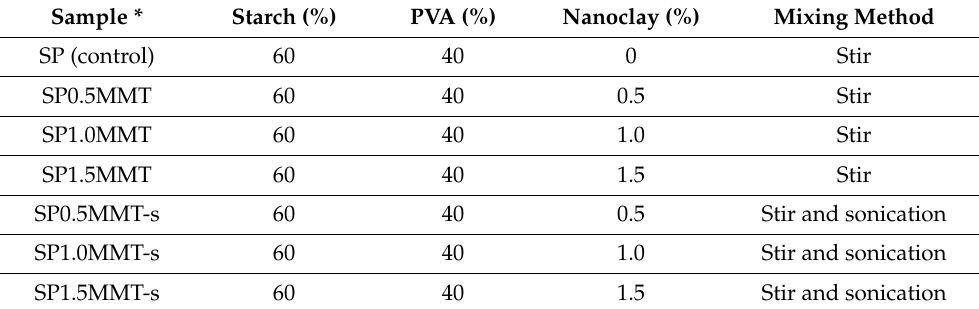
Table 5. Composition of the films based on achira starch, and polyvinyl alcohol, with MMT nanoclay. Sample * Starch